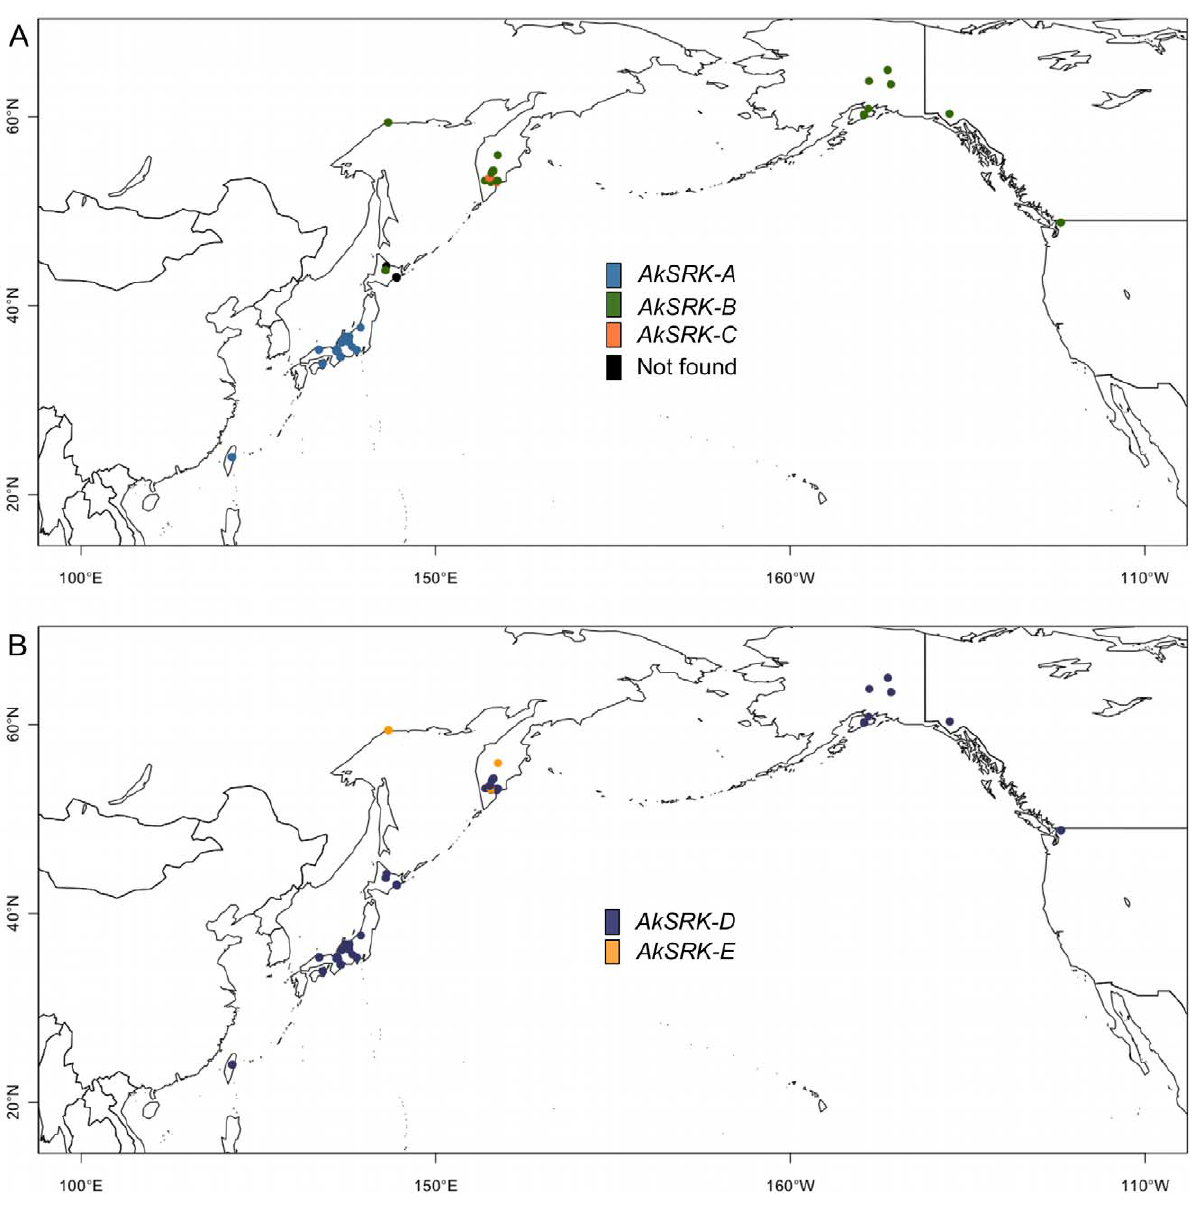
Figure 4. Geographic distribution of S -haplogroups in A.kamchatica . (A) Geographic distribution of AkSRK-A (blue), AkSRK-B (green) and AkSRK-C (orange). Black circles: not found. (B) Geographic distribution of AkSRK-D (purple) and AkSRK-E (dark